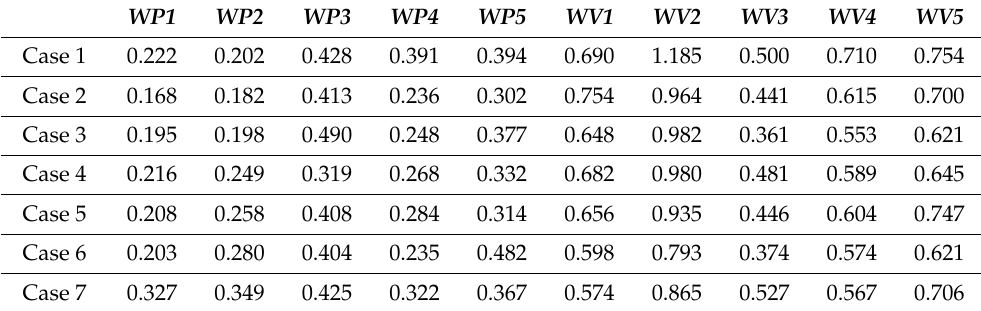
Table 4. Values of WP j and WV j indicators for particular workstations.